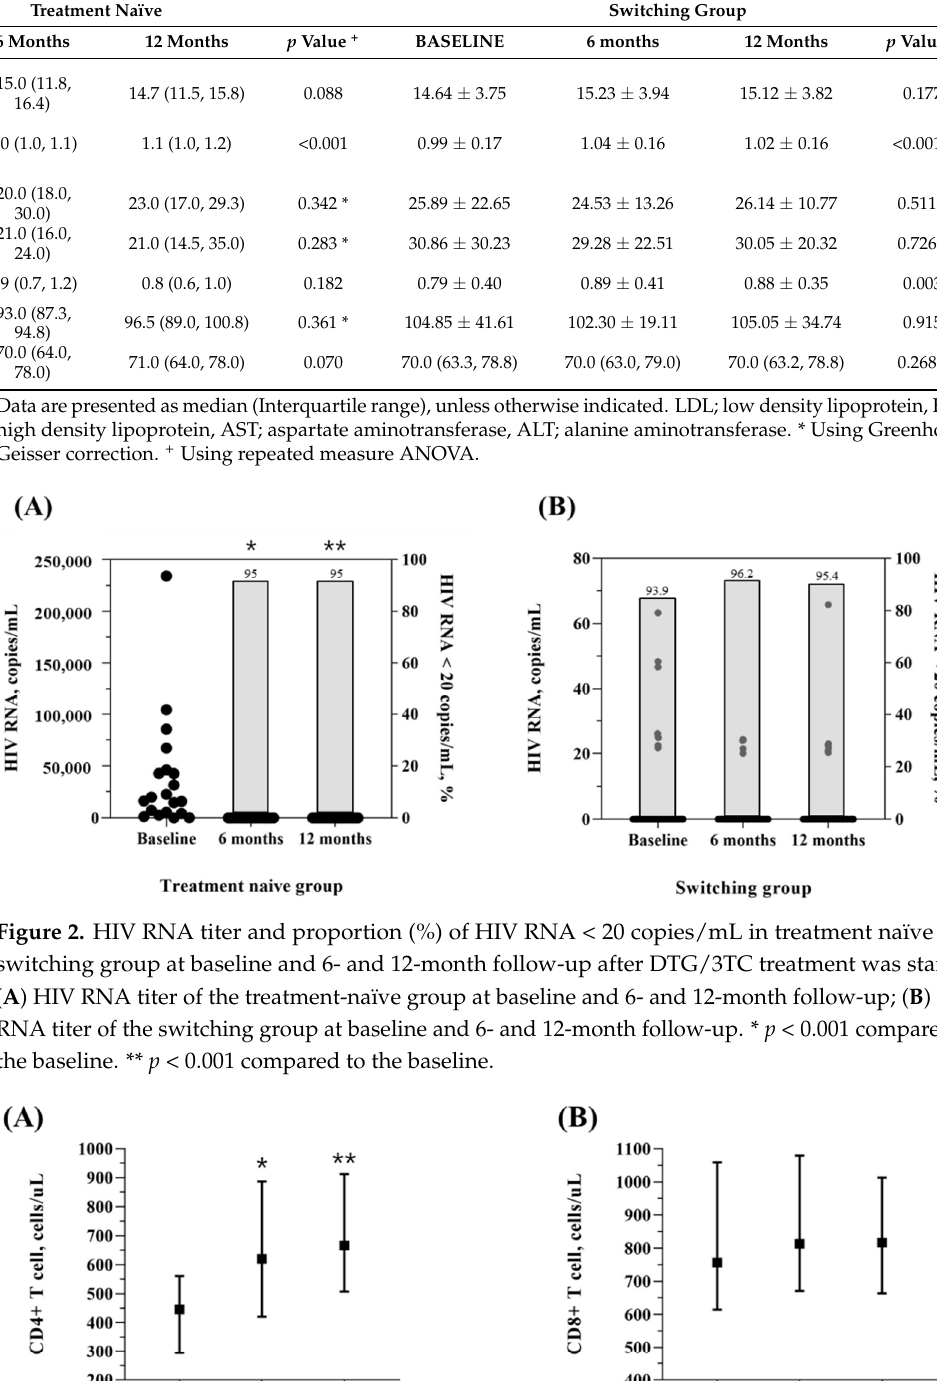
Figure 3. CD4+ and CD8+ T cell counts at baseline and 6- and 12-month follow-up after DTG/3TC treatment was started. ( A ) CD4 positive T cell counts of the treatment-naïve group at baseline and 6- and 12-month follow-up; ( B ) CD8 positive T cell counts of the treatment-naïve group at baseline and 6- and 12-month follow-up; ( C ) CD4 positive T cell counts of the switching group at baseline and 6- and 12-month follow-up; ( D ) CD8 positive T cell counts of the switching group at baseline and 6- and 12-month follow-up. * p < 0.001 compared to the baseline. ** p < 0.001 compared to the baseline.